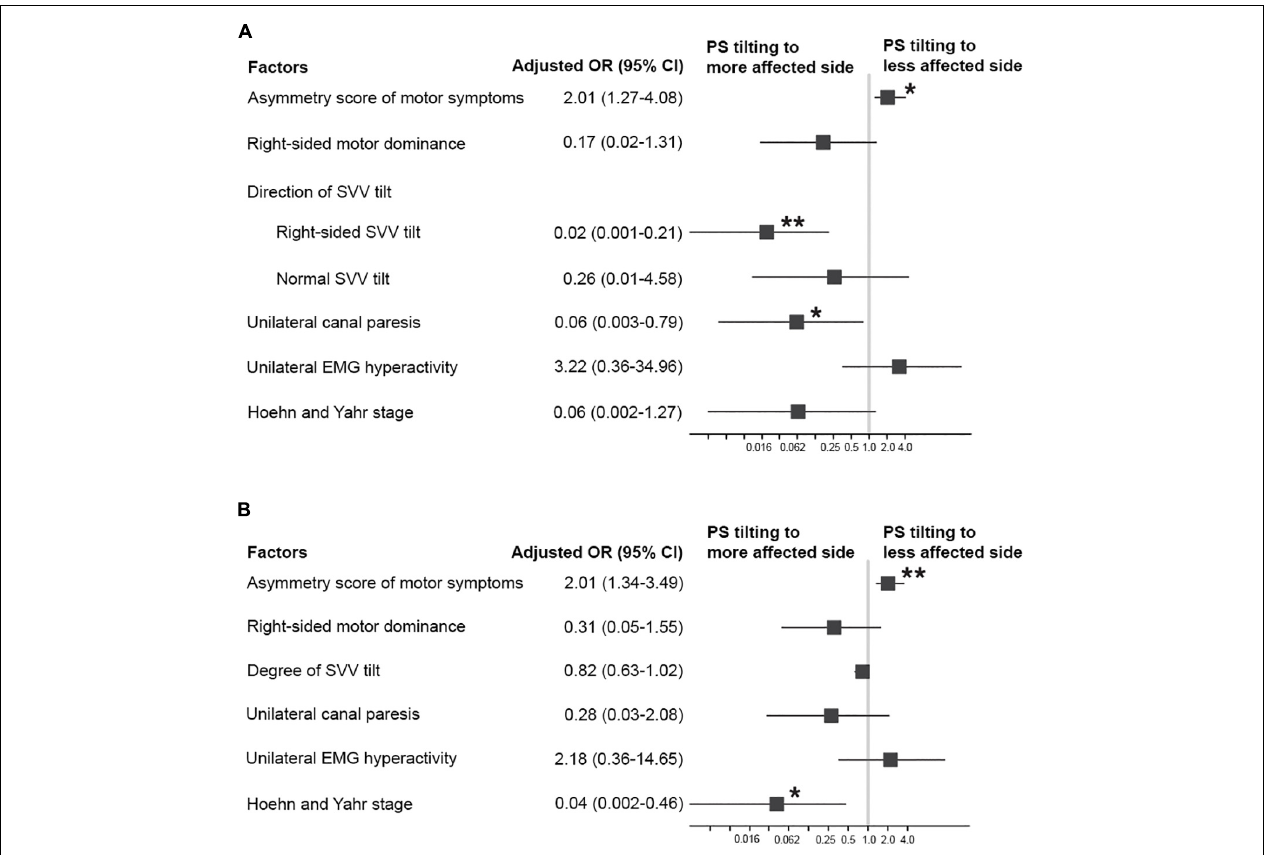
FIGURE 2 | Factors associated with PS tilting to the less affected side in patients with PD. (A) Adjusted odds ratios (ORs; square) and 95% CI (error bars) from a multivariable logistic regression model including the direction of SVV tilt. (B) Adjusted ORs (square) and 95% CI (error bars) from a multivariable logistic regression model including the degree of SVV tilt. * p < 0.05, ** p <